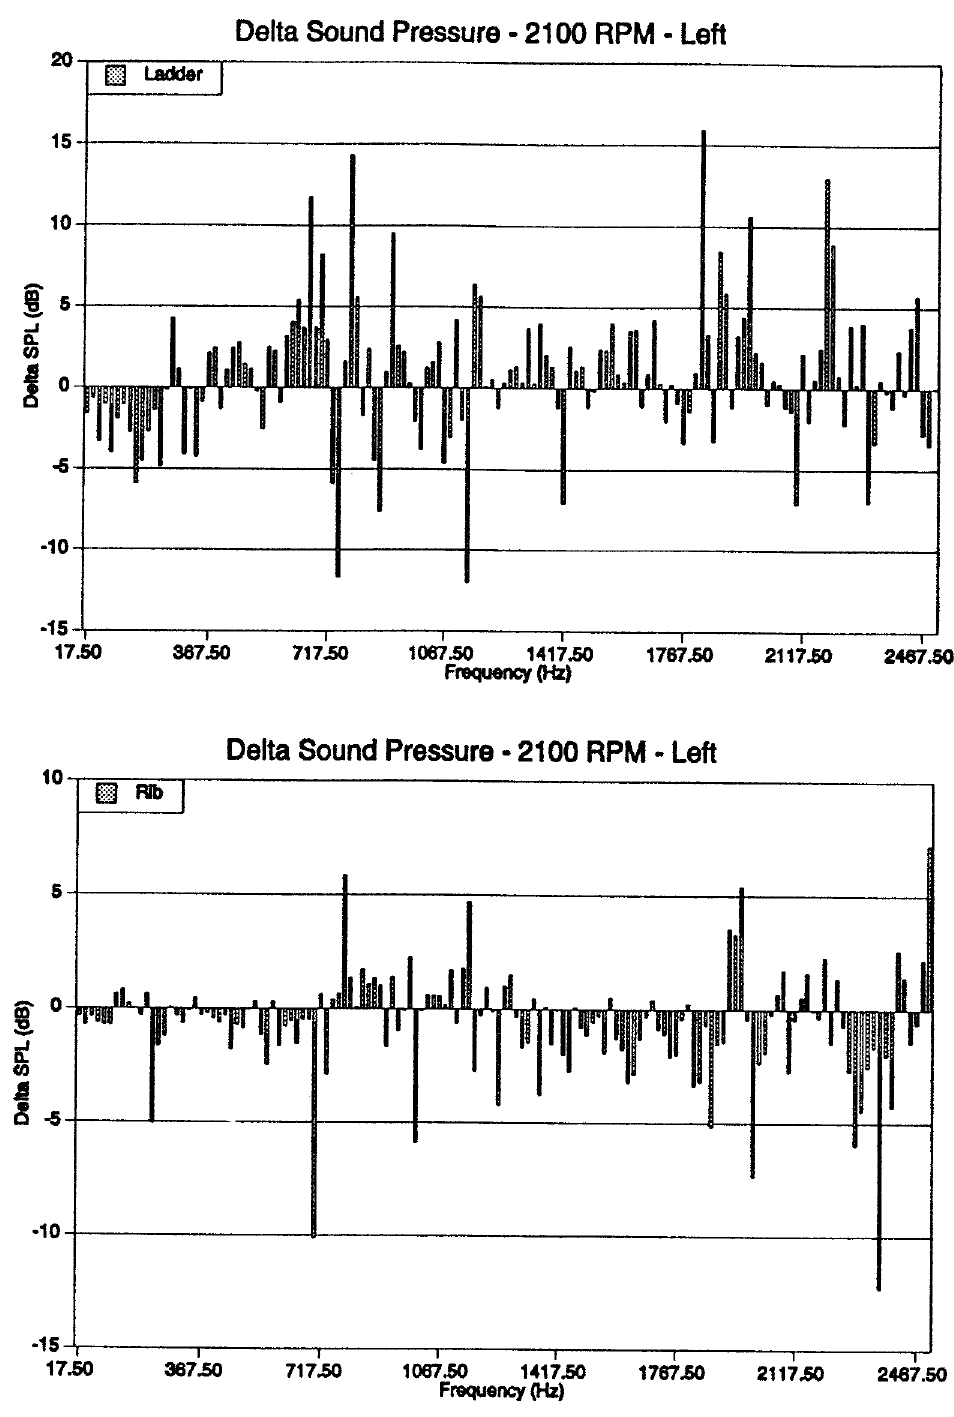
Fig. 11. Change in the acoustic response at the left side of the